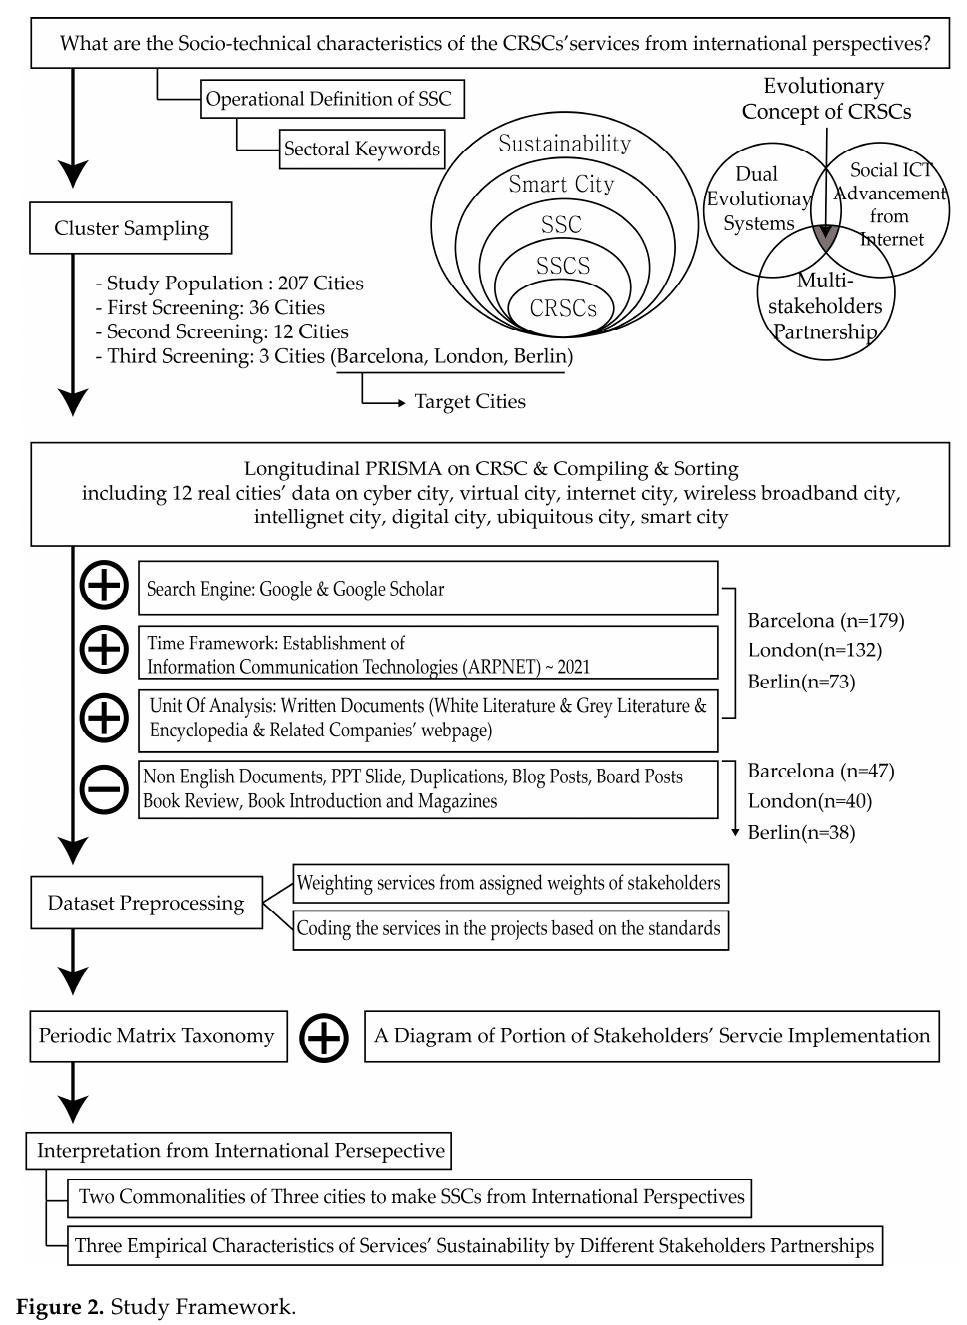
Figure 2. Study Framework.